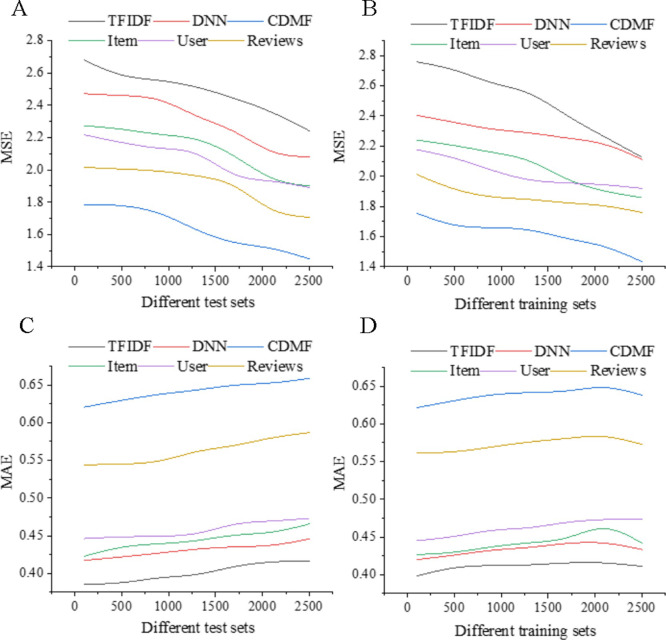
Impact of the improved model on prediction results.